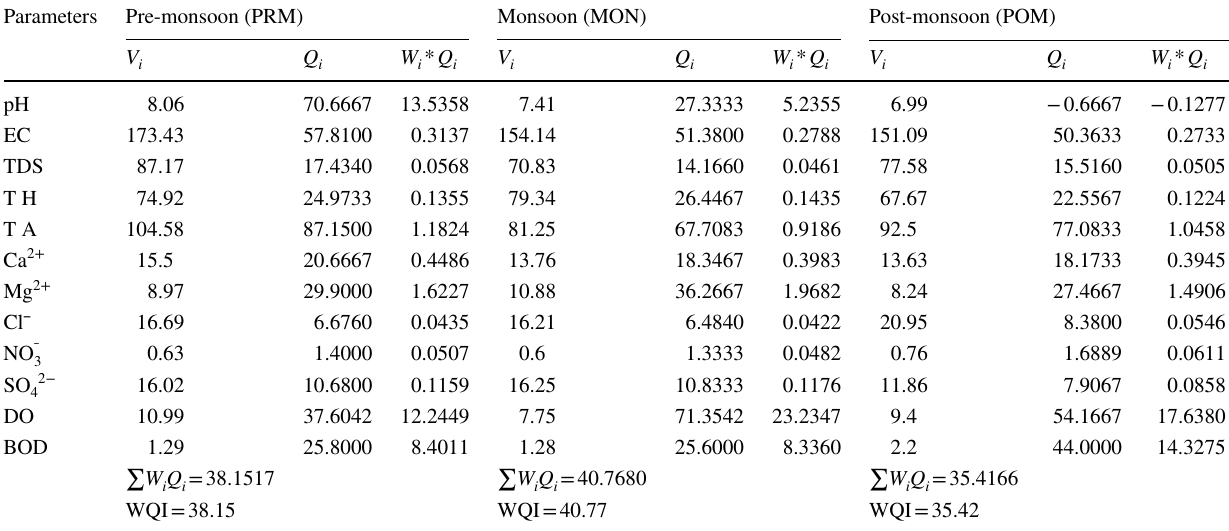
Table 11 Calculation of WQI at station 7 (S 7)